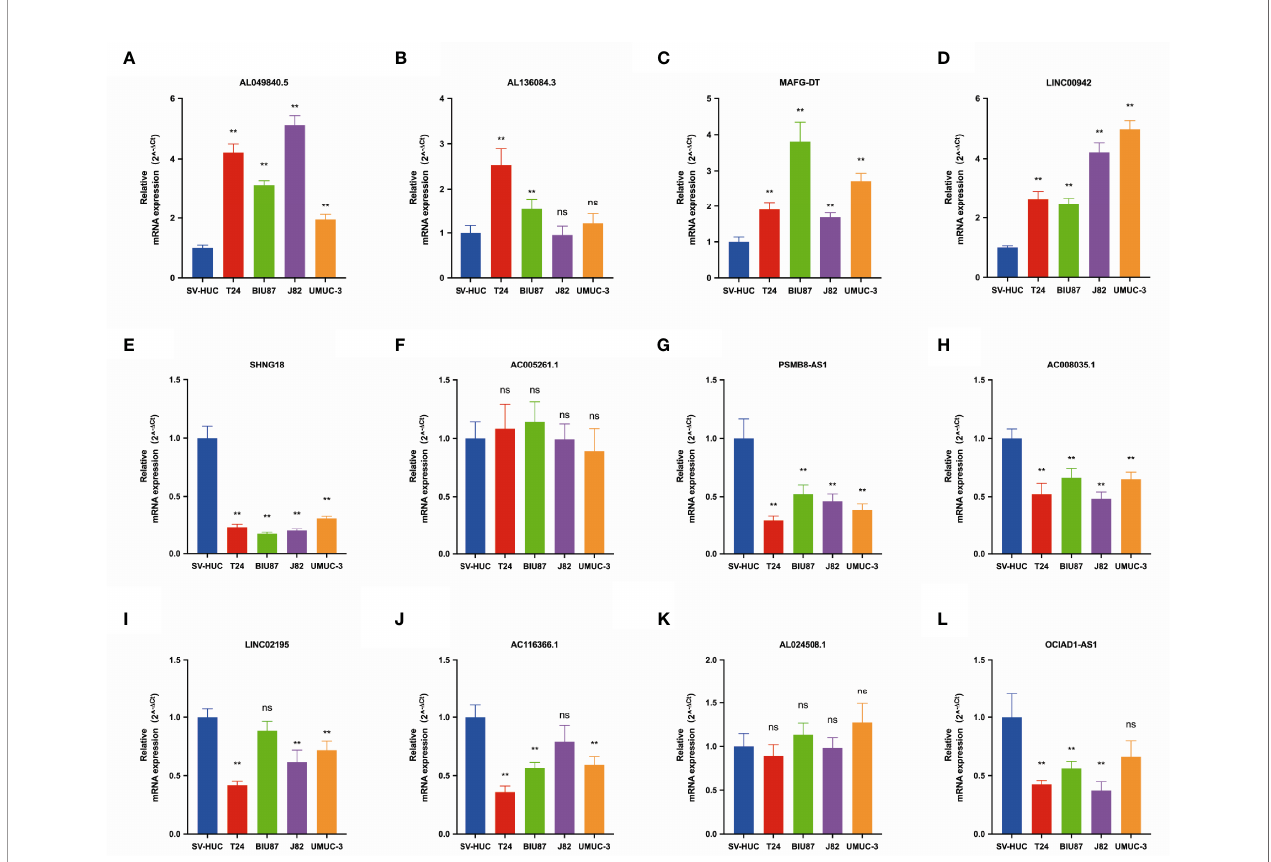
FIGURE 2 | The qRT-PCR results of 12 lncRNAs in four bladder cancer cell lines. Notes: (A) qRT-PCR result of AL049840.5; (B) qRT-PCR result of AL136084.3; (C) qRT-PCR result of MAFG-DT; (D) qRT-PCR result of LINC00942; (E) qRT-PCR result of SNHG18; (F) qRT-PCR result of AC005261.1; (G) qRT-PCR result of PSMB8-AS1. (H) qRT-PCR result of AC008035.1. (I) qRT-PCR result of LINC02195. (J) qRT-PCR result of AC116366.1. (K) qRT-PCR result of AL024508.1. (L) qRT-PCR result of OCIAD1-AS1. **P < 0.01. ns, not statistically signi fi